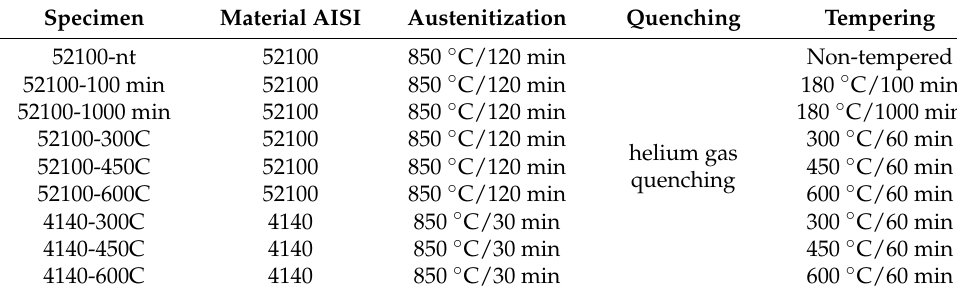
Table 2. Specimen designation and applied heat treatment.